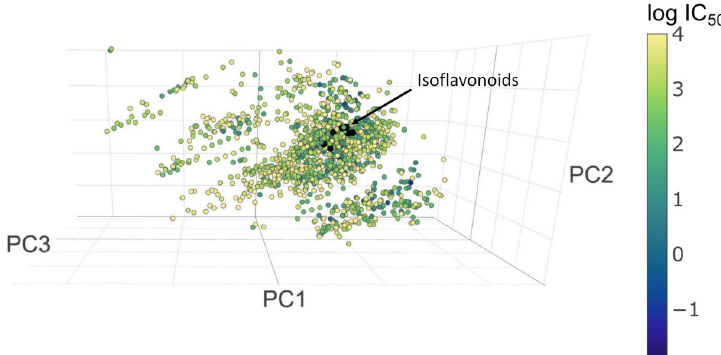
Fig 5. The location of MAO-B inhibitors and Ononis isoflavonoids in chemical space (blue color correlates with lower IC 50 values, yellow with higher